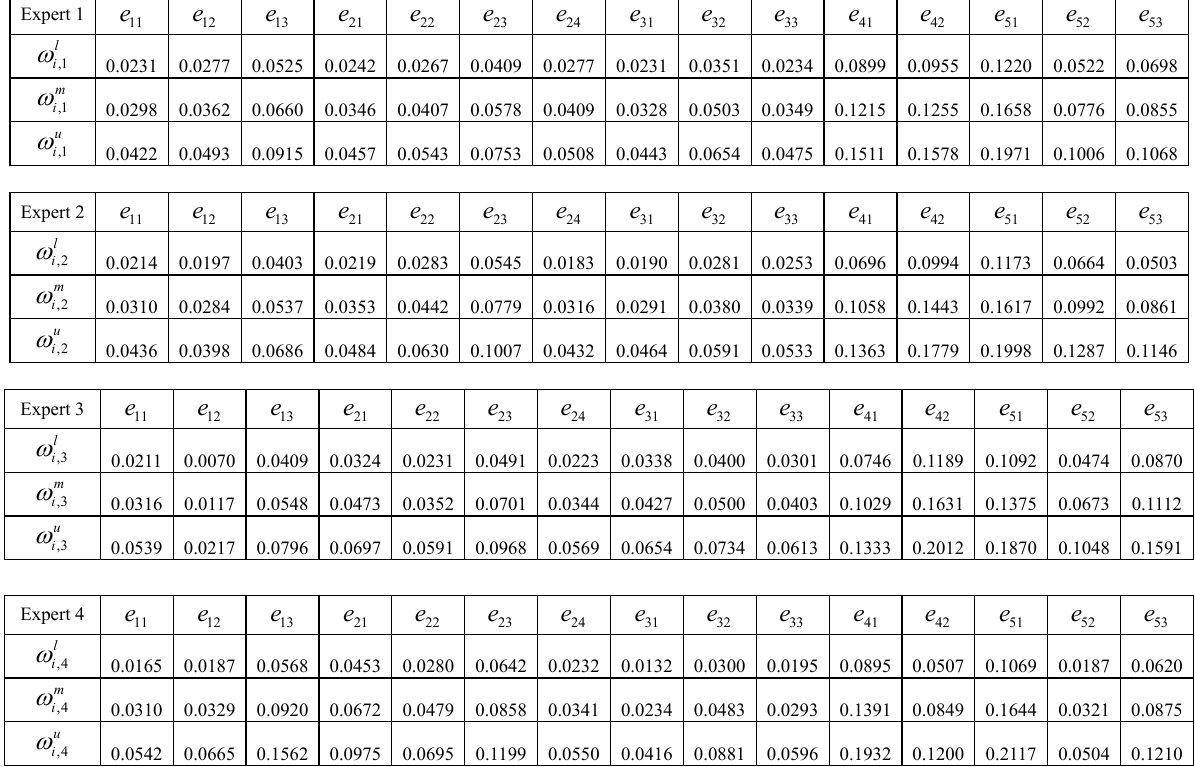
Table 3. The abstract triangular fuzzy weights of attributes generated from 4 experts by FAHP Expert